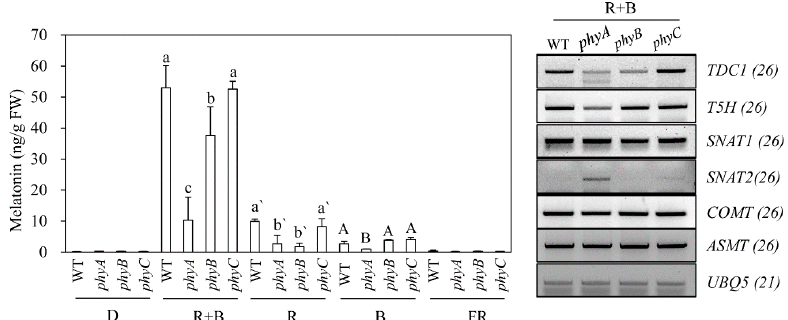
Figure 4. Effects of various light wavelengths on melatonin synthesis in phy mutants. ( A ) Melatonin levels in response to cadmium treatment under various light conditions in phy mutants. ( B ) Expression levels of melatonin biosynthetic genes. Seven-day-old rice seedlings were rhizosperically challenged with 0.5 mM CdCl 2 for 3 days under various light wavelength condition as described in Figure 1. Values are means ± standard deviations of three independent experiments. FW, fresh weight. Di ff erent letters denote significant di ff erences as determined by Tukey’s post hoc HSD test at P < 0.05. GenBank numbers are presented in Figure